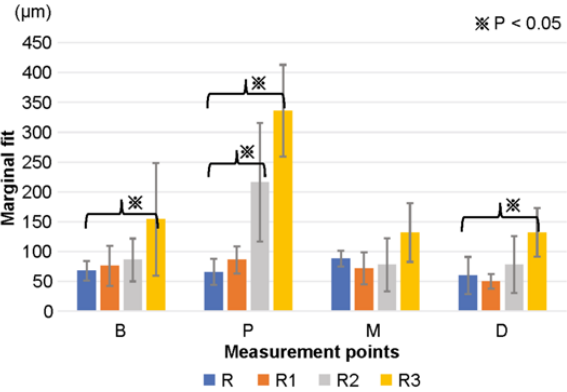
Figure 3. Mean and standard deviation of the marginal goodness of fit for each model and provi- sional crown were measured using SYNAPSE VINCENT ® . The results for all models of R, R1, R2, and R3 are